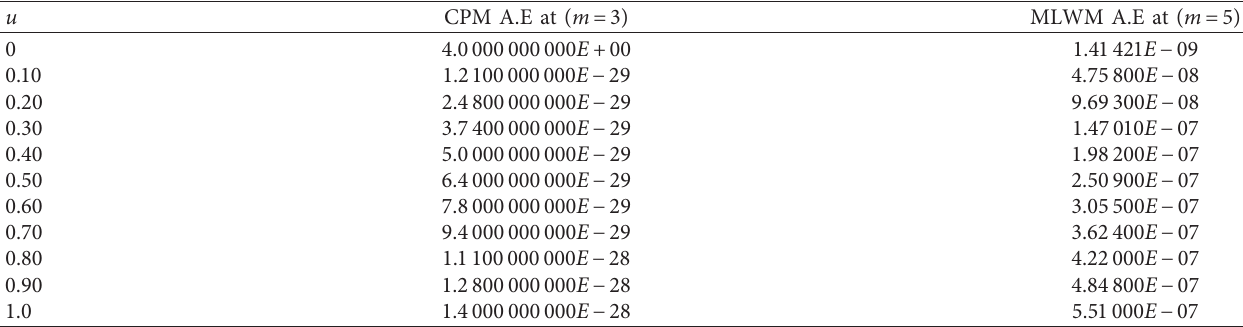
Table 6: Absolute error (A.E) comparison of CPM and other different methods of problem 3.